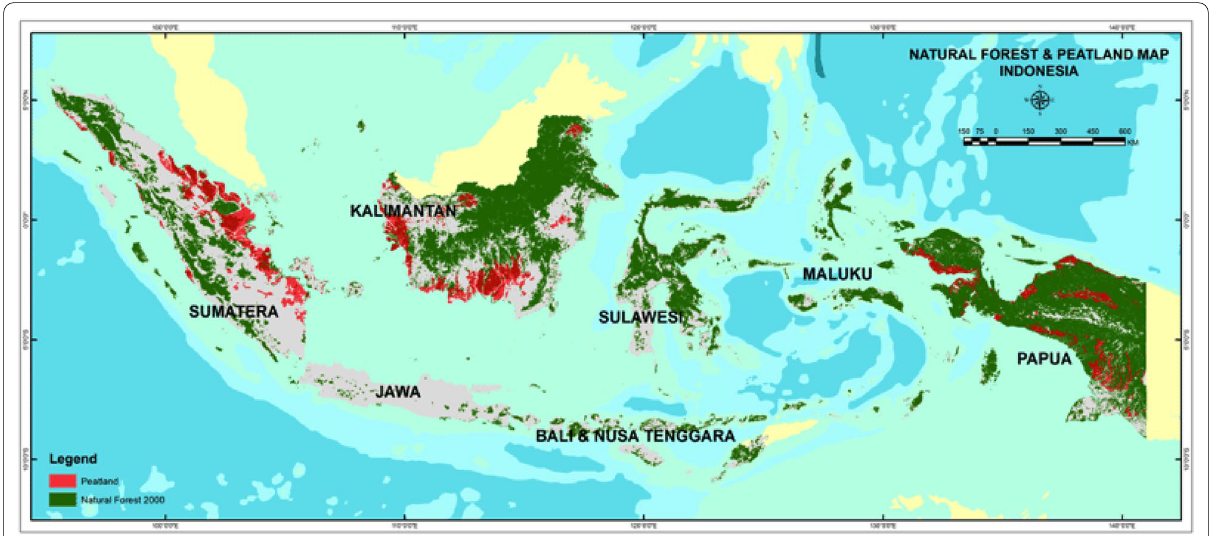
Fig. 1 Environmental issues are illustrated by deforestation and forest degradation mapping in Indonesia. Source: BP-REDD (BP-REDD , 2015), www. reddp lus. go. id downloaded on March 28, +